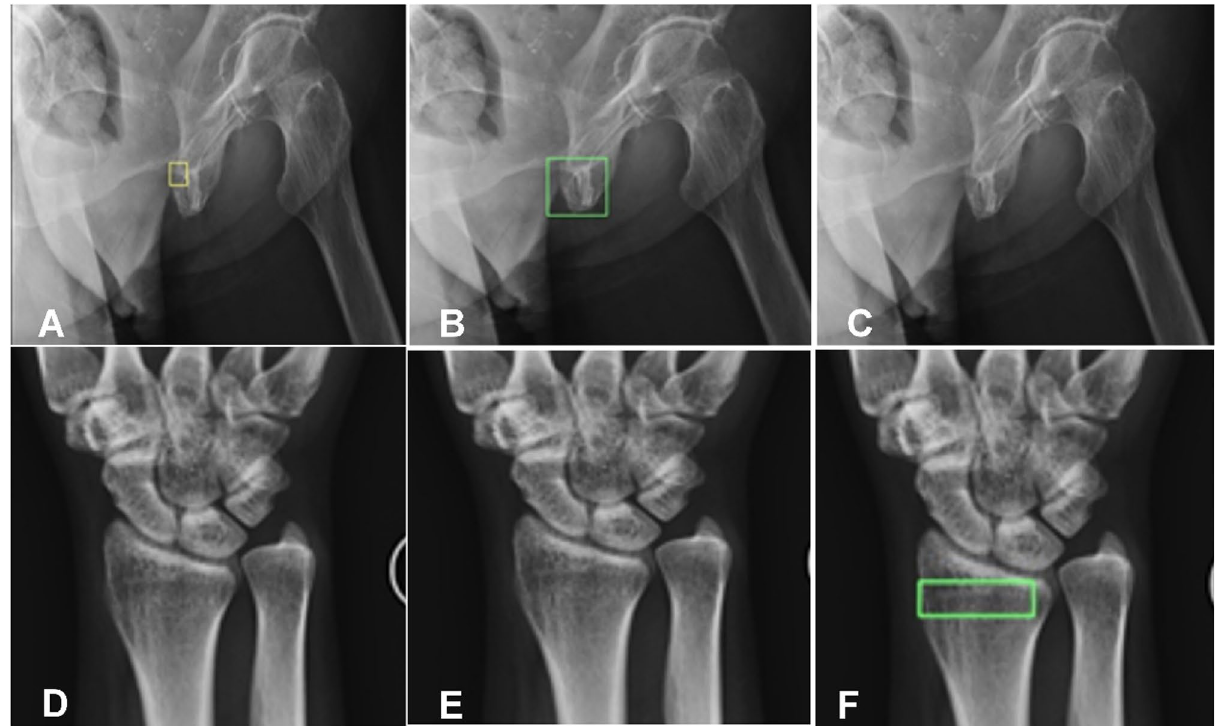
Figure 3. Effects of the FAMO (Feature Ambiguity Mitigate Operator) plus ResNeXt101+FPN model and the ResNeXt101+FPN model only, with the FAMO plus ResNeXt101+FPN model being helpful in finding bone fractures. ( A ) A minor fracture was marked by the radiologist (small box) on the radiograph. ( B ) The fracture line was successfully recognized by the FAMO plus ResNeXt101+FPN model (green box). ( C ) The ResNeXt101+FPN model did not recognize the fracture. No fracture line was detected on the radiograph by the radiologist ( D ) or by the FAMO plus ResNeXt101+FPN model ( E ). But the ResNeXt101+FPN model (causing feature distortion) detected a false positive fracture line ( F , green